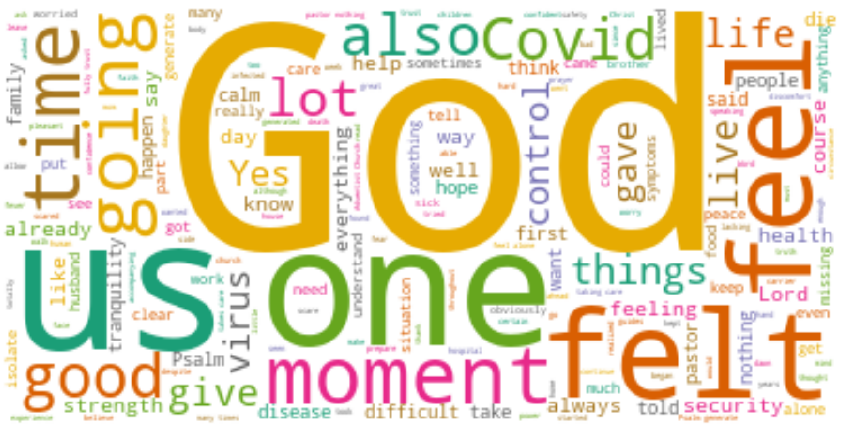
Figure 3. Word cloud from interviews COVID-19